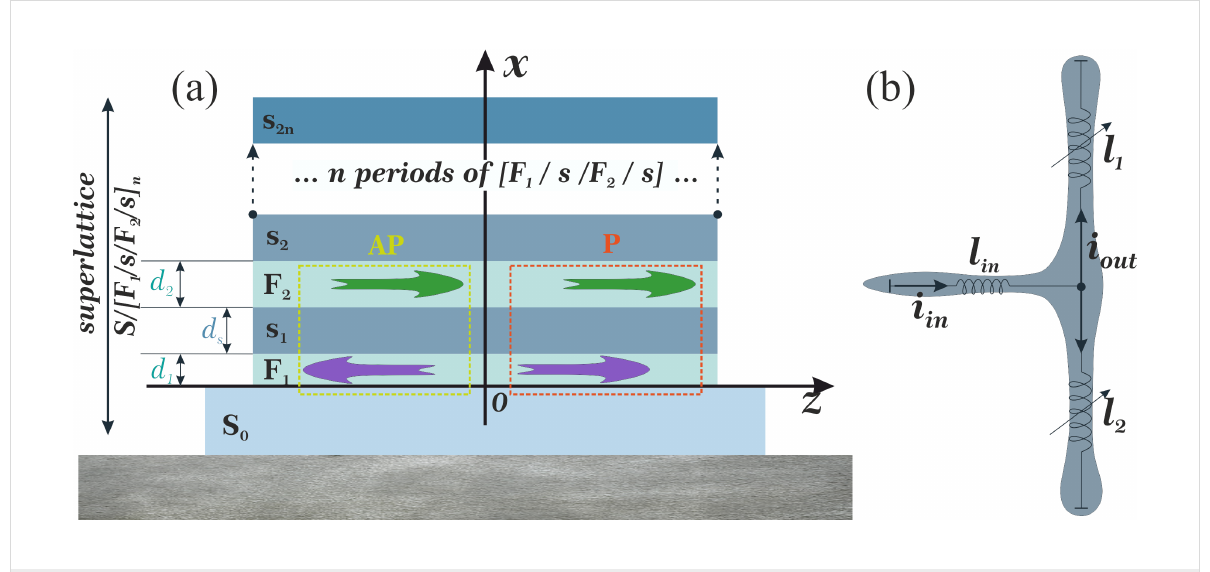
Figure 1: (a) Sketch of the investigated multilayer Co(1.5 nm)/Nb(6 nm)/Co(2.5 nm)/Nb(6 nm) structure. (b) The simplest splitter model based on this